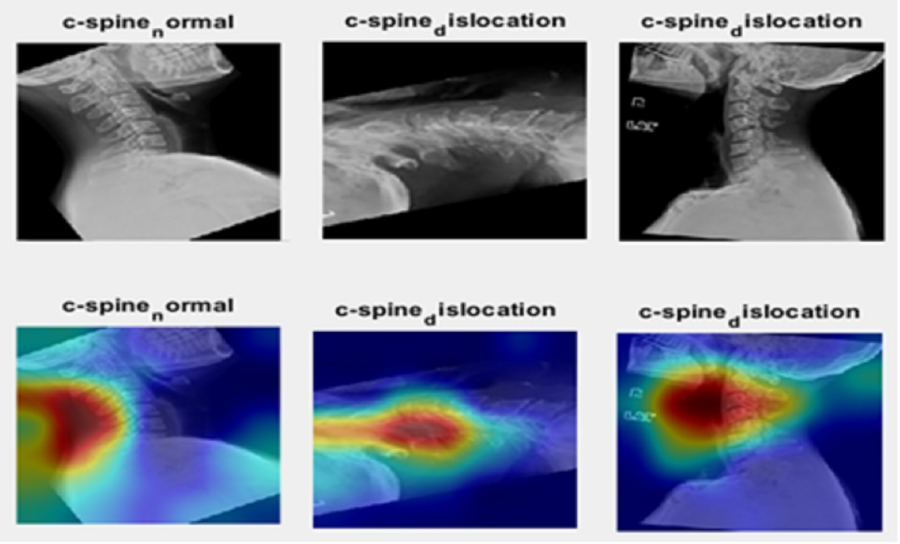
Figure 15. The first row is the image from the dataset with some rotation; the second row is the saliency map for the same